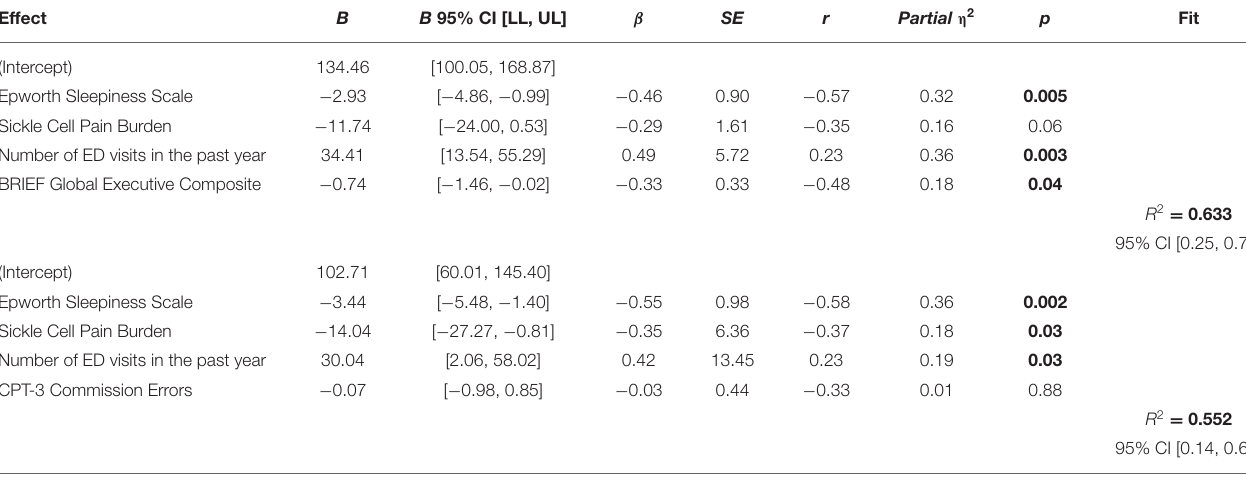
TABLE 4 | Two regression model with health-related quality of life (PedsQL) as the dependent variable and sleepiness (ESS), pain burden (SCPBI-Y), ED visits within the past year, with either executive function (BRIEF GEC) or CPT commission errors as predictors.